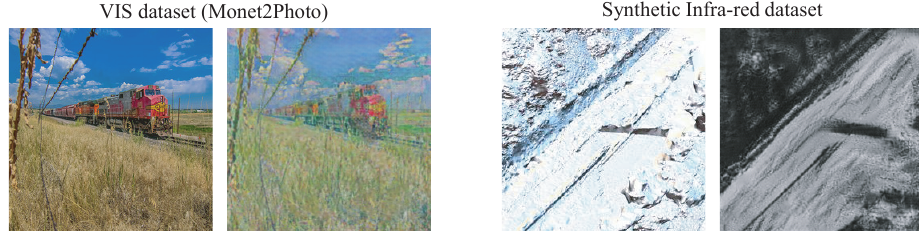
Figure 1. A single example of learning general dataset (Monet2Photo) and synthetic infra-red dataset. Compared to the VIS data, synthetic IR data were not learned